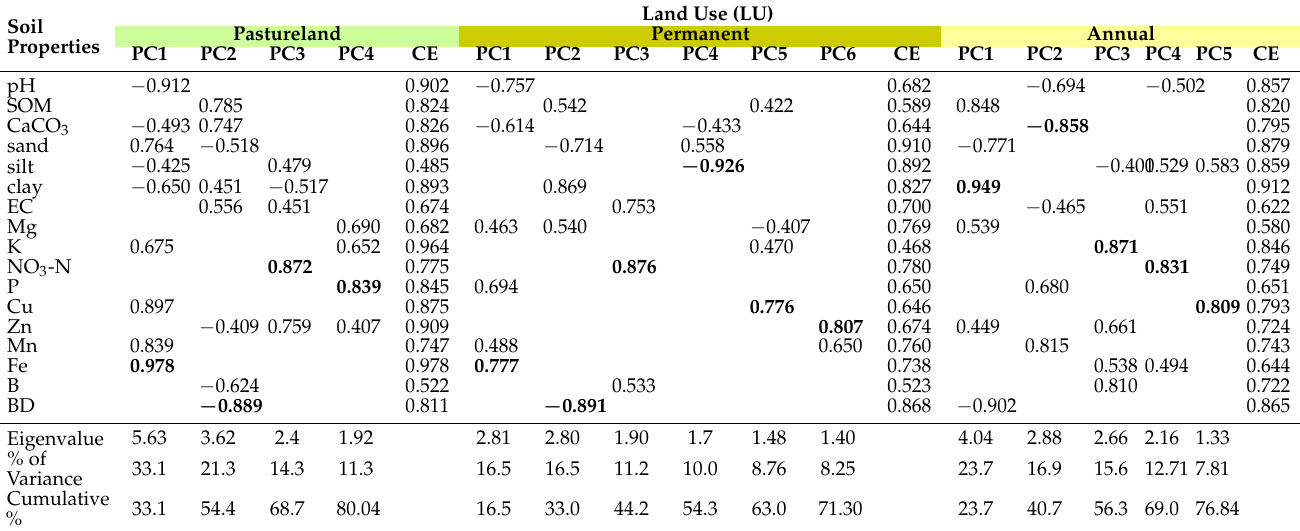
Table 5. Results of the principal component (PC) analysis of soil properties for different land